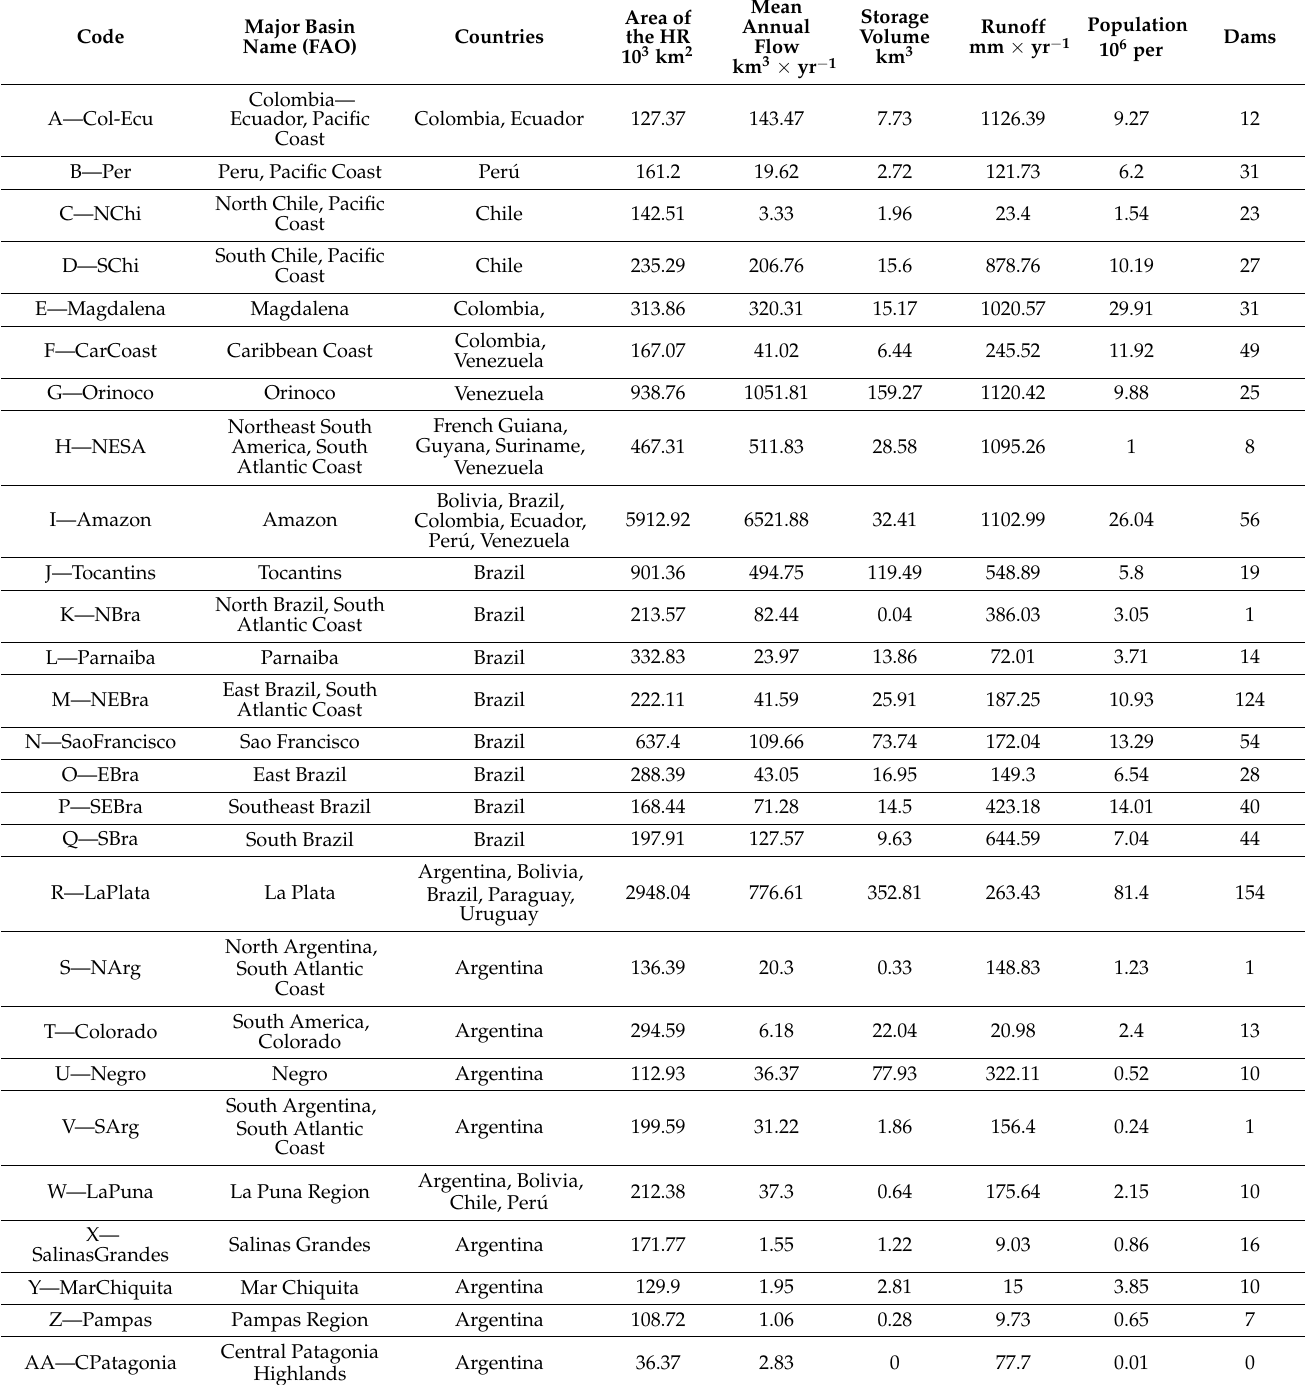
according to the continent’s 27 hydrological regions considered in this study. The results of the 4661 catchments are presented in the Supplementary Materials Section. Table 1. Main characteristics of the Hydrological Regions (HR) considered for this